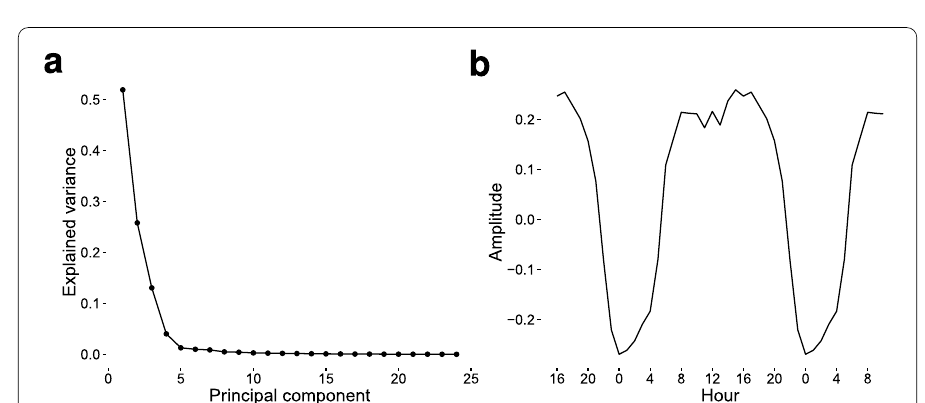
Figure 2 Activity of counties in the space of 12am and 1pm. Each dot represents a county, and the horizontal axis measures the relative tweeting activity between 12am and 1am in that county, while the vertical axis represents the relative tweeting activity between 1pm and 2pm in that county. As these two measures are correlated, a linear transformation could combine them into a single coordinate. The new coordinate axis is represented by the dashed line. The black arrow points to the average of the measures along the original axes. The blue and the red arrows are possible choices for A and B vectors, see Section 2.4.